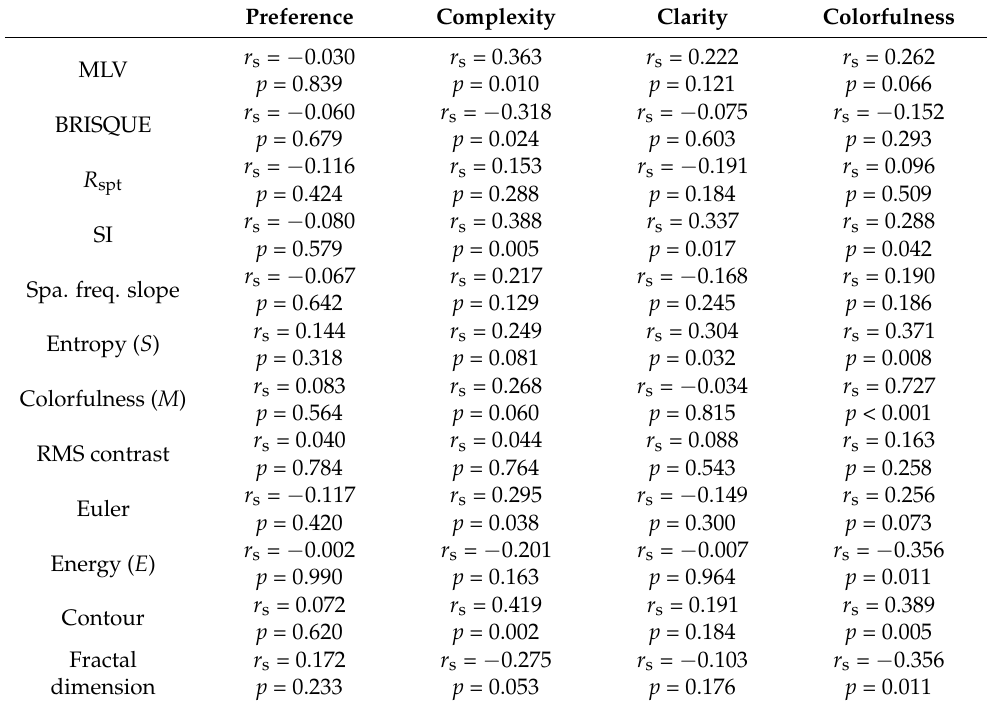
Table 3. Spearman’s correlation coefficient ( r s ) and p -values ( p ) between image quality metrics and subjective